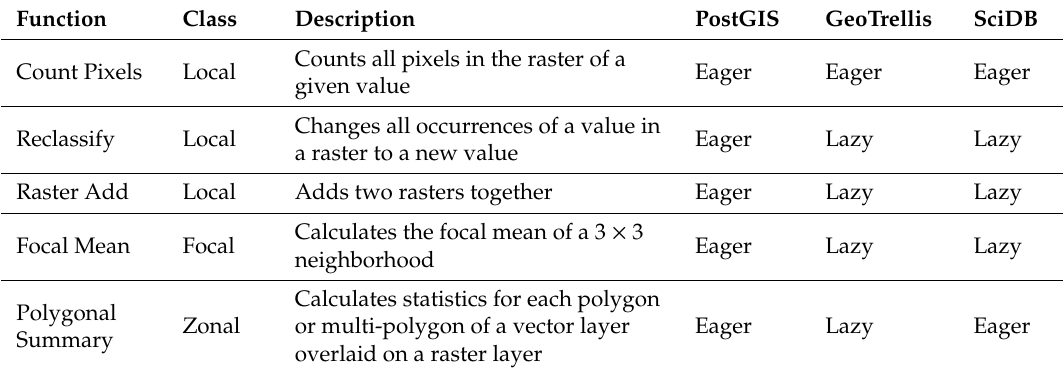
Table 3. Description of raster operations by platform with evaluation